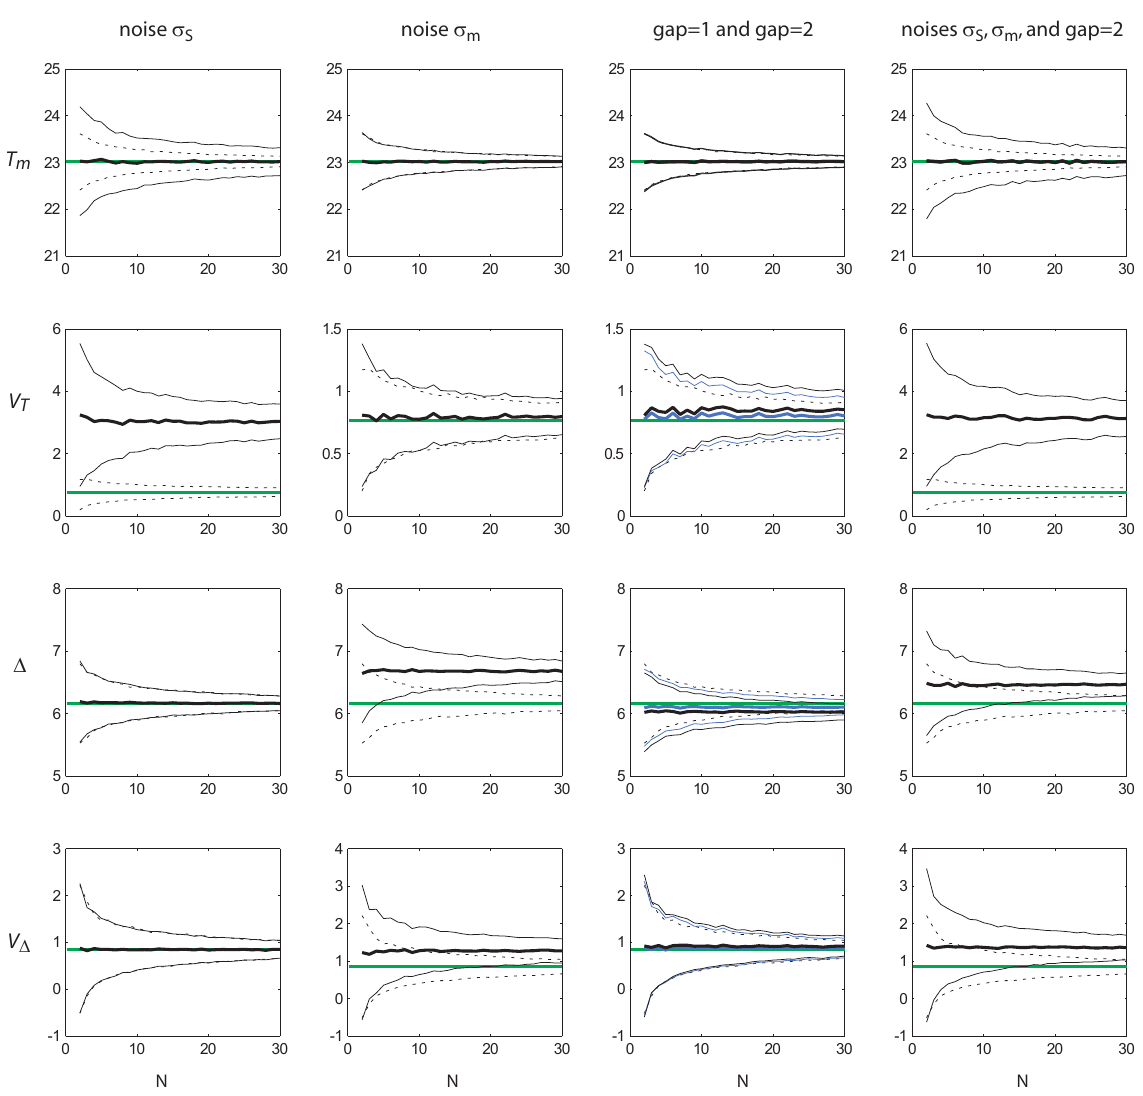
Fig. 2. Results of experiment 1 with the 1950–2009 Ni˜no1+2 SST time series. Mean values of T m , V T , 1 , and V 1 (black bold lines) calculated from 5000 iterations of surrogate proxy simulations (MoCo algorithm), and compared to the true values (green) of the target time series, versus the sample size (e.g. number of shells). Systematic errors are indicated by the difference between the mean calculated value and the true value. Dotted lines show the standard error interval ( ± 1 σ ) for an ideal proxy (no signal perturbation) versus the sample size. Thin black lines show the standard error interval ( ± 1 σ ) for surrogate proxies with stochastic noise. In the first three columns, the effects of spatial variability ( σ S ), monthly variability ( σ m ), and the occurrence of random growth breaks (blue: 1 per year, black: 2 per year) are investigated separately. Their effects are combined in the fourth